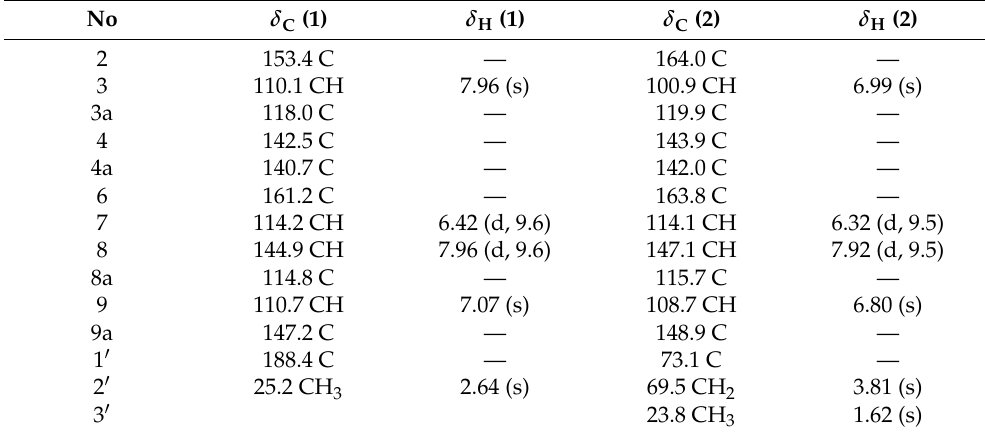
Table 1. 1 H and 13 C NMR data of compounds 1 and 2 , δ in ppm and J in Hz.